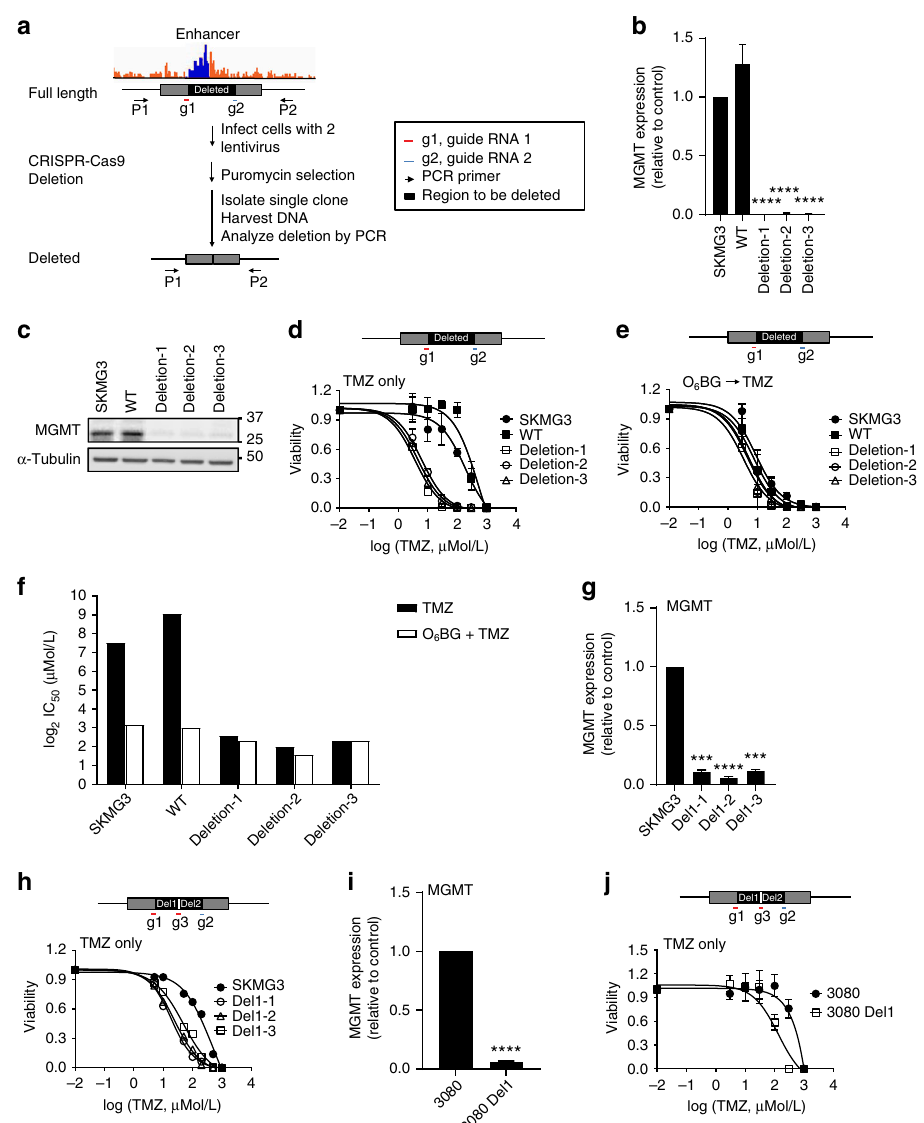
Fig. 5 Enhancer deletion reduces MGMT expression and increases sensitivity to TMZ. a An outline of deletion strategy using CRISPR/Cas9 system. Cells were infected with a mixture of two virus containing guide RNAs surrounding K-M enhancer locus. After puromycin selection, single clones were isolated and tested by PCR. b MGMT expression in SKMG3 parental cell, SKMG3 wild-type clone, and three K-M enhancer-deleted clones were analyzed by quantitative RT-PCR. MGMT transcript level was fi rst normalized to actin and subsequently calculated as fold change relative to SKMG3 parental line. c MGMT protein levels in SKMG3 parental cell, SKMG3 wild-type clone, and three K-M enhancer-deleted clones were tested by western blotting. α -Tubulin was used as loading control. d SKMG3 parental line, wild-type clone, and K-M enhancer-deleted clones were treated with indicated concentrations of temozolomide (0 – 1000 µ M/L fi nal concentration). Cell viability was determined using clonogenic assay. e SKMG3 parental line, wild-type clone, and K-M enhancer-deleted clones were treated with 10 µ M O 6 BG 1 h prior to temozolomide (0 – 1000 µ M/L fi nal concentration). Cell viability was determined using clonogenic assay. f Bar graph showing log 2 (TMZ IC 50 ) in SKMG3 clones with or without O 6 BG pre-treatment. g MGMT expression in SKMG3 parental cells and three Del1 deleted clones were analyzed by quantitative RT-PCR. MGMT transcript level was fi rst normalized to actin and subsequently calculated as fold change relative to SKMG3 parental line. h SKMG3 parental cells and three Del1 deleted clones were treated with indicated concentrations of temozolomide (0 – 1000 µ M/L fi nal concentration). Cell viability was analyzed using clonogenic assay. i MGMT transcription levels in 3080 parental